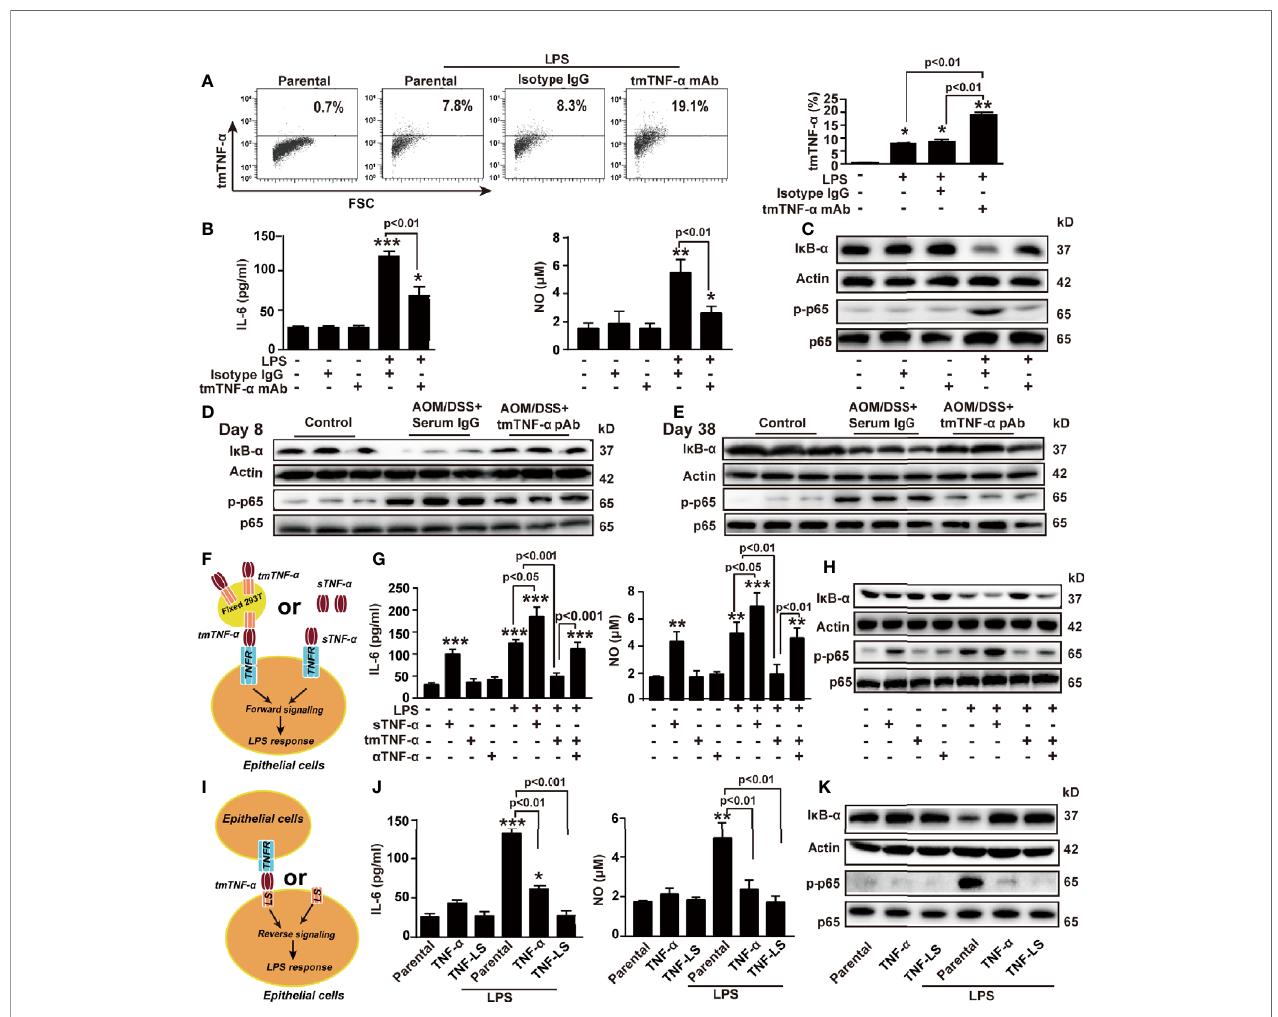
FIGURE 8 | tmTNF- a actively suppresses LPS-induced production of in fl ammatory mediators via dual signaling. NCM460 cells were stimulated with 10 ng/ml LPS combined with 2 m g/ml of tmTNF- a mAb for 6 h. Isotype IgG served as a control. (A) tmTNF- a expression on the cell surface assessed by fl ow cytometry and quantitative data. (B) Concentrations of IL-6 and NO in culture supernatants at 10 h after stimulation. (C) Representative western blot of three independent experiments for I k B a degradation and p65 phosphorylation at 1 h after stimulation. (D, E) Mice were intraperitoneally injected with 600 m g tmTNF- a pAb twice a week starting on day 5 followed by AOM/DSS treatment. Normal rabbit serum IgG served as a control. Western blot analysis of the NF- k B pathway on day 8 and day 38. (F – H) NCM460 cells were cocultured with 100 ng/ml sTNF- a or tmTNF- a stably expressed on the cell surface of fi xed 293T cells at a ratio of 1:10 in the presence of 10 ng/ml LPS (F) . Concentrations of IL-6 and NO in culture supernatants at 10 h after stimulation (G) , and representative western blot of three independent experiments for the NF- k B pathway at 1 h after stimulation (H) . (I – K) TNF- a and TNF-LS stably transfected NCM460 cells (I) and their parental cells were stimulated with 10 ng/ml LPS for 10 h (J) Levels of IL-6 and NO. (K) Representative western blot of three independent experiments for the NF- k B pathway at 1 h after LPS stimulation. All quantitative data represent as means ± SEM of four independent experiments. *P < 0.05, **P < 0.01, ***P < 0.001 versus control for (A, B, G) , versus parental for (J)